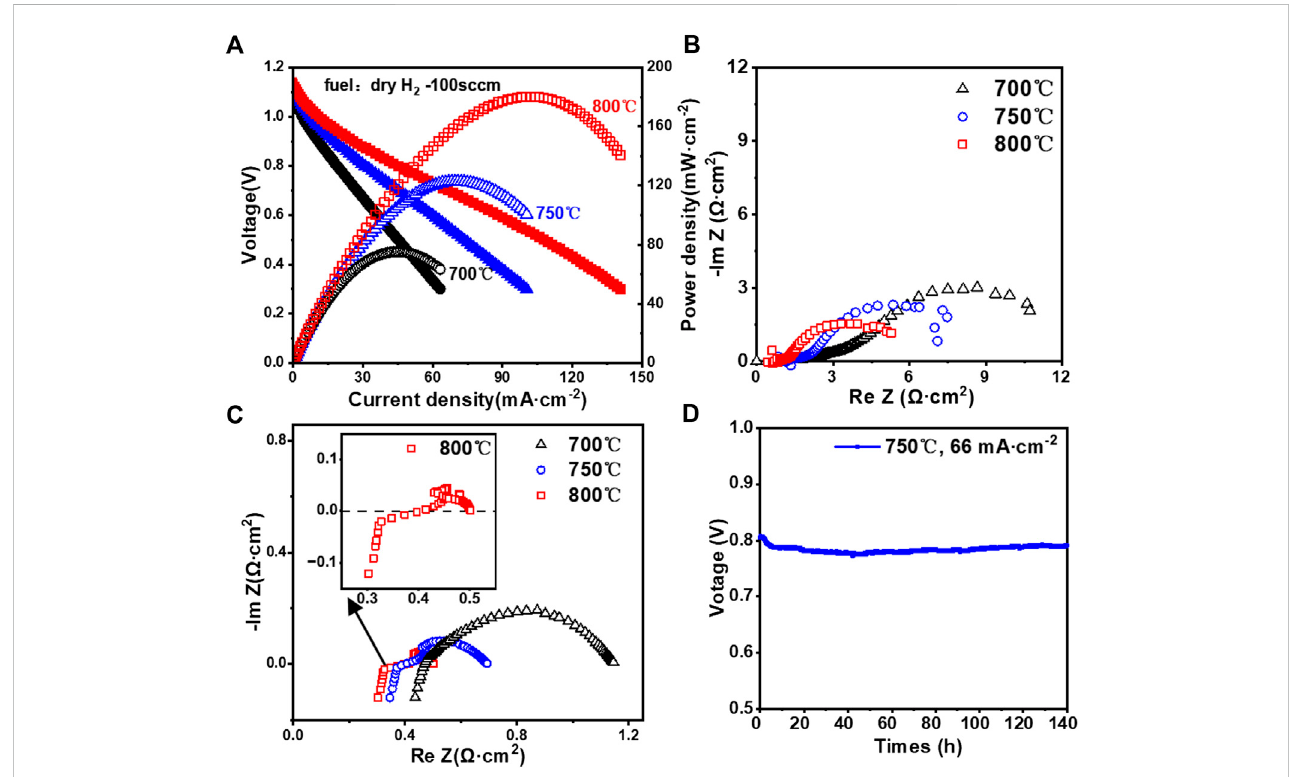
FIGURE 12 (A) MS-SOFC button cell I – V curve; (B) EIS of the MS-SOFC button cell; (C) EIS results of ultrasonic pyrolysis-sprayed LSCF cathodes at different temperatures; and (D) short-term stability test for a cell similarly prepared as in (A)